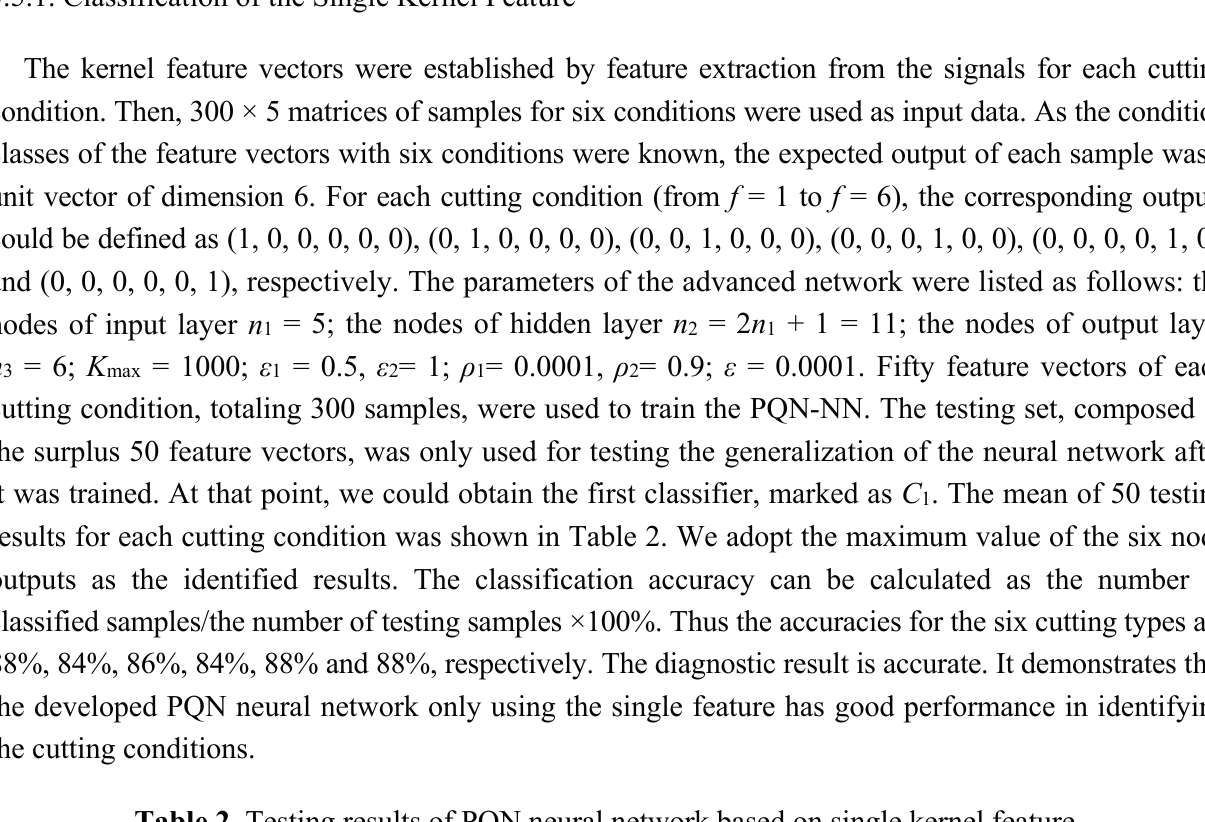
Table 2. Testing results of PQN neural network based on single kernel